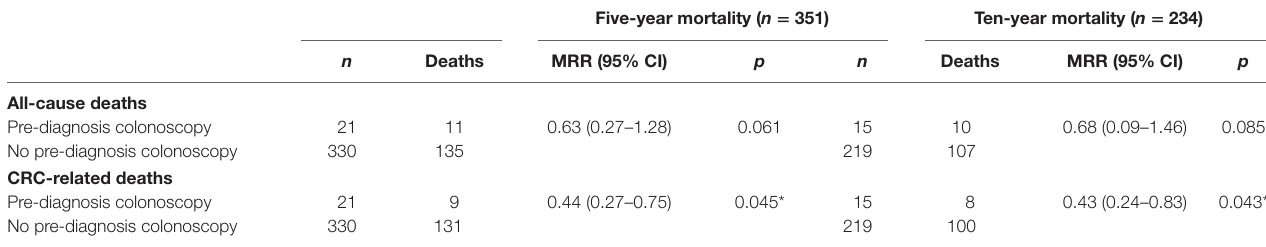
Table 3 | Five- and ten-year colorectal cancer (CRC)-related mortality for adolescents and young adults with and without pre-diagnosis